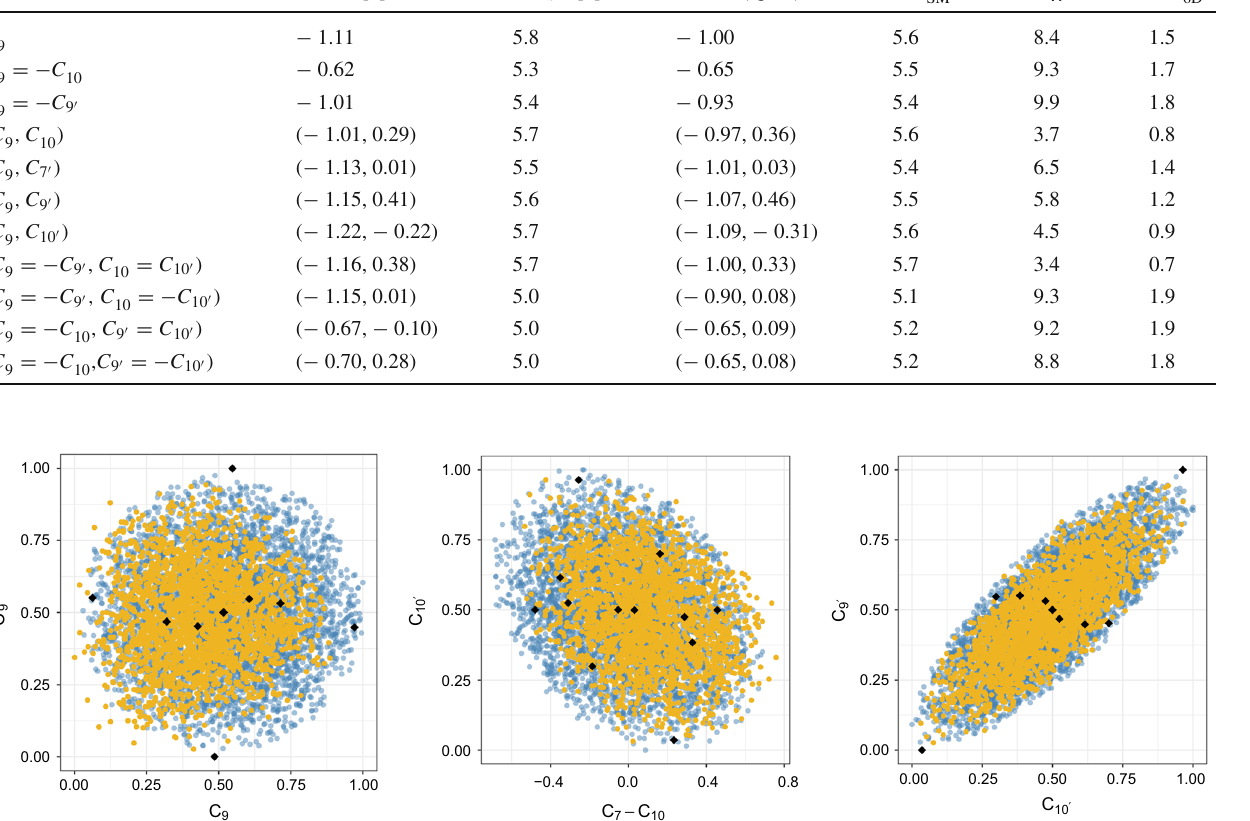
space The black diamonds are the twelve SVD points listed in Table 9, which i sit on the boundary of this